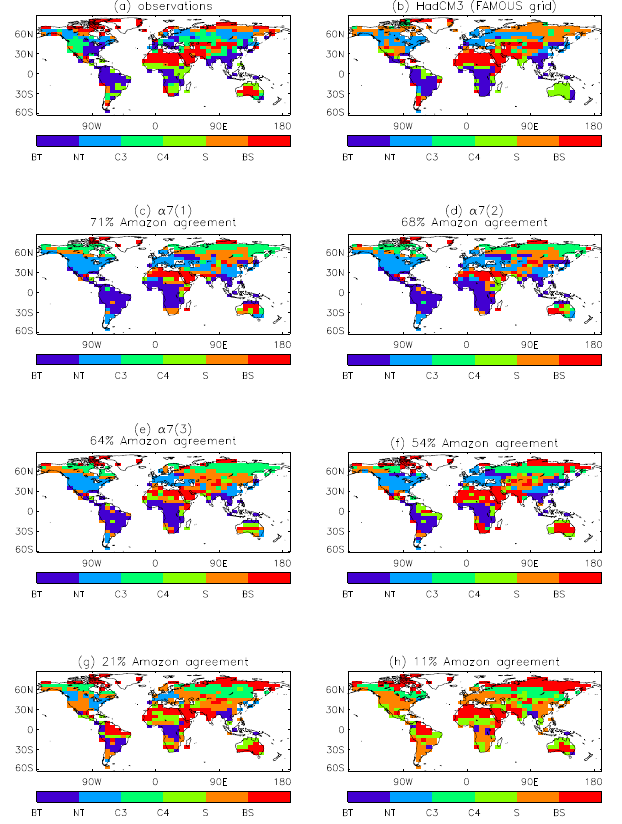
Fig. 4. Dominant grid-box PFT for (a) observations, (b) HadCM3, regridded to the FAMOUS resolution (c–e) the three top performing α 7 ensemble members in terms of their fractional agreement with observations over the Amazon region, (f–h) three ensemble mem- bers with decreasing Amazon agreement. There is a clear correla- tion between the agreement over the Amazon region and that over the whole globe.